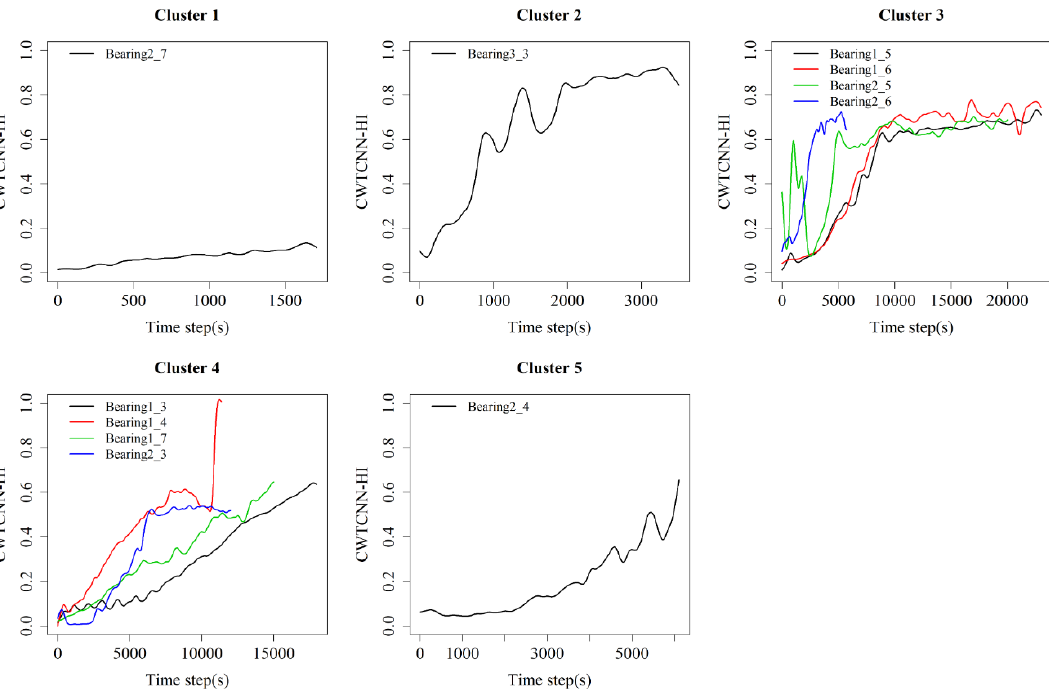
Figure 12. Clustering results of the testing datasets.